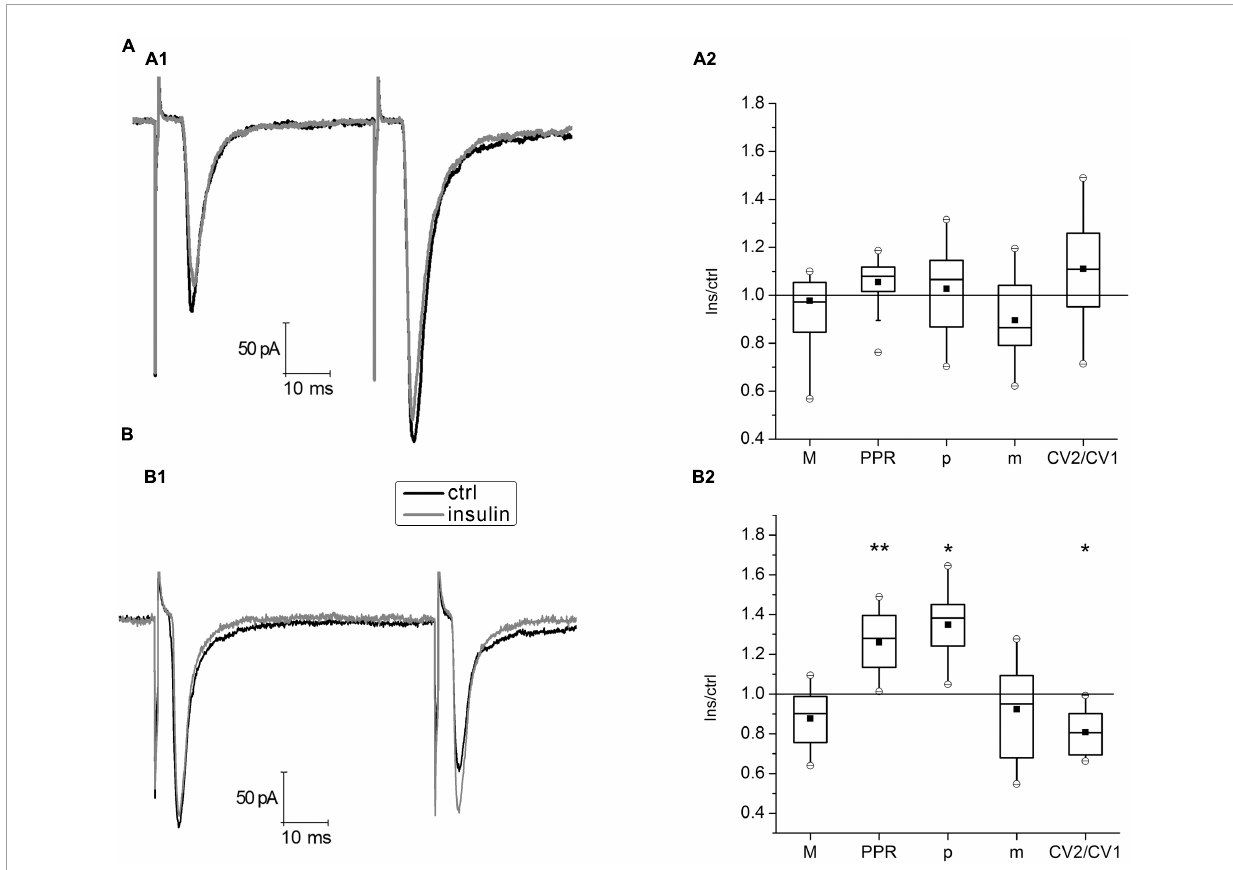
FIGURE3 Insulin action on paired-pulse plasticity of evoked glutamatergic excitatory postsynaptic currents (eEPSCs) at glutamatergic synapses of hippocampal neurons under hypoinsulinemia. (A) Paired-pulse facilitation (PPF) under 100 nM insulin addition. (A1) Average traces of eEPSCs pairs in control (ctrl) and after insulin application (Insulin) in the same single cell. (A2) The box charts show average changes of PPF parameters amplitudes (M), coefficient of variation (CV), paired pulse ratio (PPR), release probability ( p ), and quantal content ( m ) (same as in Figure 1 ) under insulin action compared with those measured before insulin addition (control) at the same synapses (taken as 100%). Differences of corresponding values with those in control were not significant (Student’s paired t -test, P > 0.17, n = 17). (B) Paired-pulse depression (PPD) after 100 nM insulin addition. Sample traces of eEPSCs pairs (B1) and summary plot of PPD parameters changes (B2) are presented similarly, to those in (A) . Statistical significance is indicated by: * P < 0.05; ** P < 0.005 compared with control (Student’s paired t -test, n =